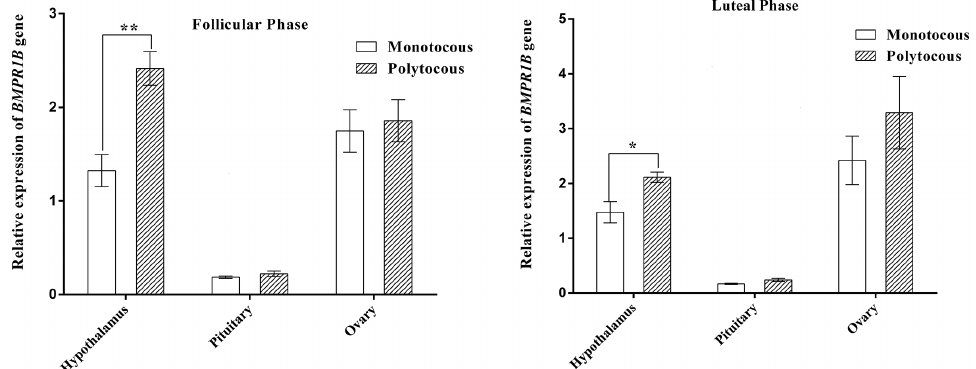
Figure 2. Relative expression of the BMPR1B gene in HPG axis tissues of small-tail Han sheep. “*” denotes significant differences, and “**” denotes extremely significant differences.